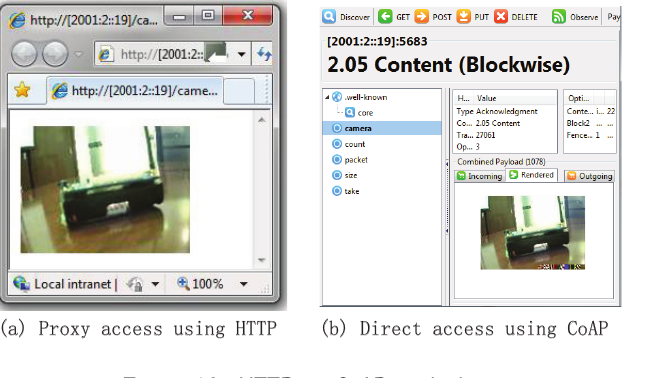
Figure 10. HTTP vs. CoAP